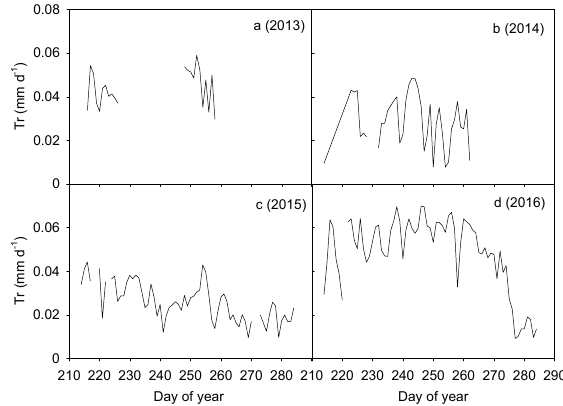
2014 and 2015 were not significant ( p ˃ 0.05).